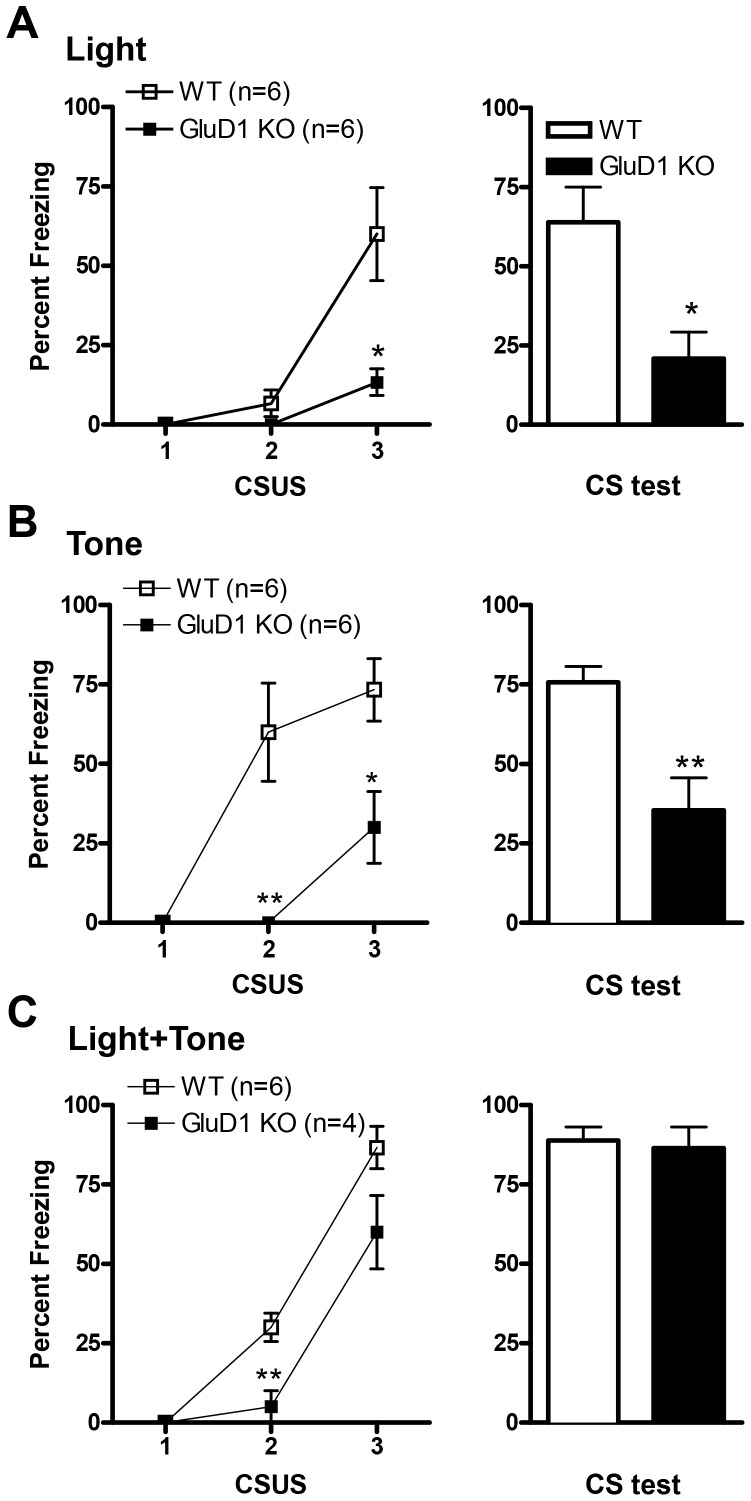
GluD1 KO mice manifest deficits in cue fear learning.
A. Significant deficit in light fear acquisition is observed in GluD1 KO mice (n = 6) during the third CS-US session compared to WT mice (n = 6) (P = 0.0118). 24 hrs after fear conditioning, in the light CS post-test GluD1 KO manifested significantly lower freezing response compared to WT mice (P = 0.0135). B. Significant deficit in tone fear acquisition is observed in GluD1 KO mice (n = 6) during the second and third pairing of the CS and US compared to WT mice (n = 6) (third CS P = 0.0178). In the tone CS post-test, GluD1 KO mice manifest a significant deficit in the freezing versus WT mice (P = 0.0093). C. Significant deficit in fear acquisition is observed in GluD1 KO mice (n = 4) during the second CS and US presentation when the CS is a tone + light cue compared to WT mice (n = 6) (P = 0.0074). In the tone + light CS post-test, no significant difference was observed between GluD1 KO (n = 4) mice compared to WT mice (n = 6) (P = 0.7711). Data are presented as mean ± SEM. ** represents P<0.01 and * represents P< 0.05.